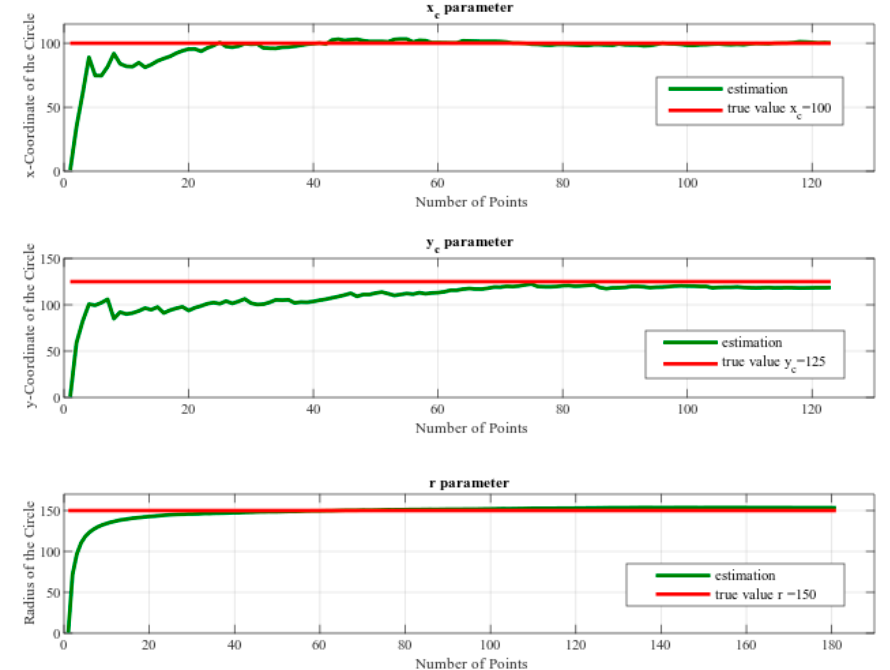
Figure 25. The simulation result of predicting ‘ x c ’, ‘ y c ’ and ‘ r ’ parameters from the circle detection. After that, we tested in the top-view transformed image of the di ff erent circular real roads. Figure 27a,b illustrates the result of curve line detection using the circle model in real road image. Here, the yellow line is the result of our algorithm and radius r = 1708.2, the center of the circle is x center = 957.81, y center = − 1260.2. Using this result we can predict road turning and based on this value of radius we can control the speed of the self-driving car. For example, if the radius value is low, the self-driving car needs to reduce speed, if the radius value is high, the self-driving car can be at the same speed (no need to reduce